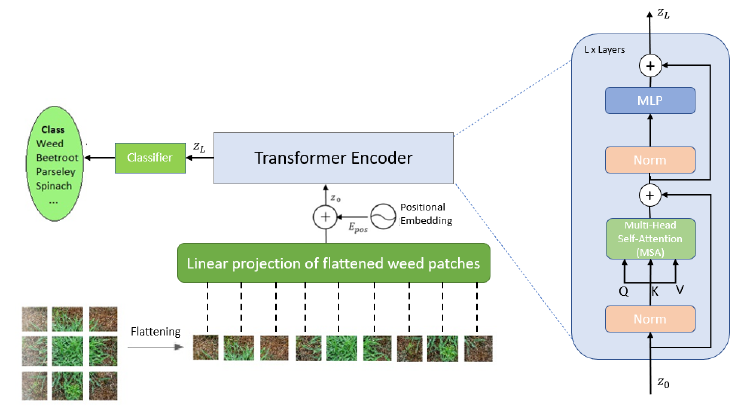
Figure 7. ViT model architecture based on original ViT model [44].